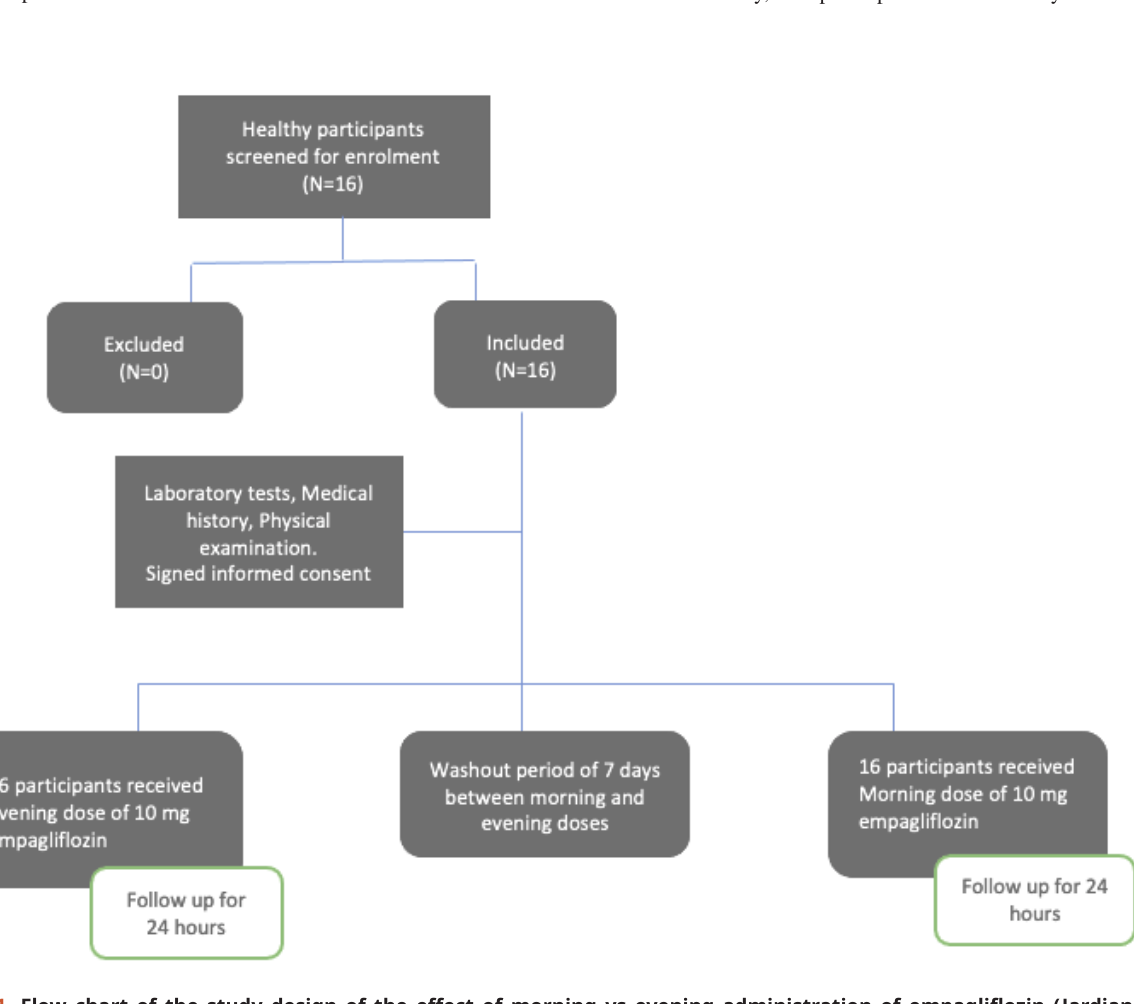
Figure 1. Flow chart of the study design of the effect of morning vs evening administration of empagliflozin (Jardiance® 10mg film coated tablet; manufactured by Boehringer Ingelheim Pharma Gmbh & Co, Germany) on its pharmacokinetics and